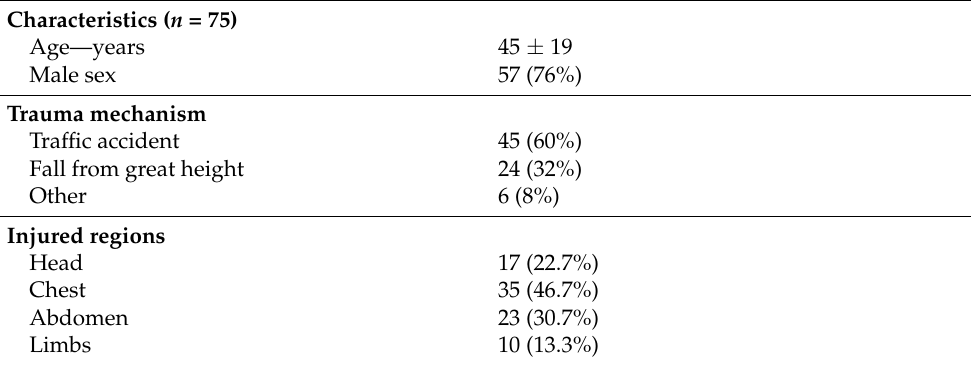
Table 1. Baseline characteristics of the 75 patients included in the analysis. Age is given as mean ± standard deviation.